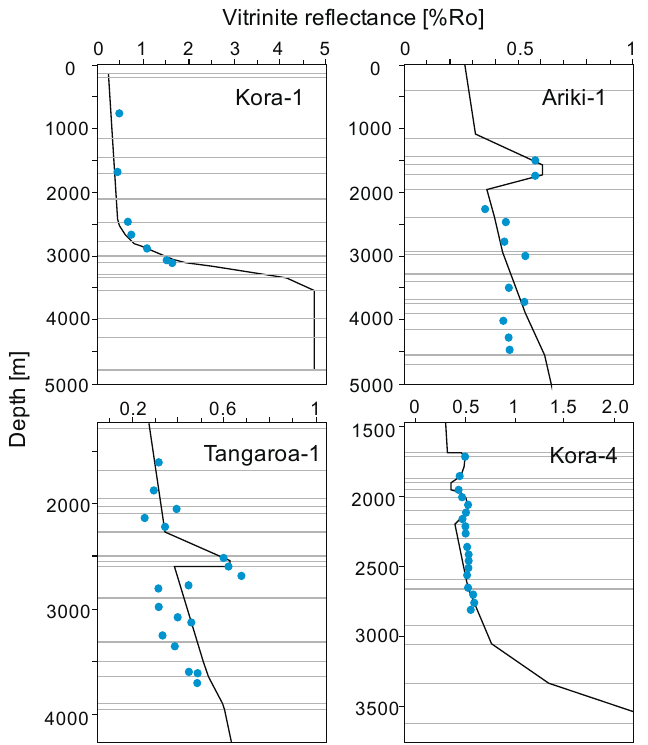
Figure 12. Vitrinite reflectance calibration for scenarios with intrusion emplacement. Only Kora-1 well has the best calibration with intrusion modeling. Kora-4, Tangaroa-1, Ariki-1 vitrinite reflectance data show a minor increase in the Miocene Volcanics unit and below it. The best calibration for these data is obtained by increasing the layer temperature to 100–150 °C. This might be indicative of hydrothermal fluid circulation.